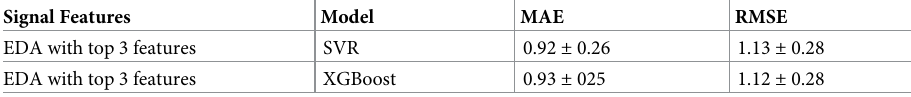
Table 7. Subject-dependent model performance with top 3 EDA